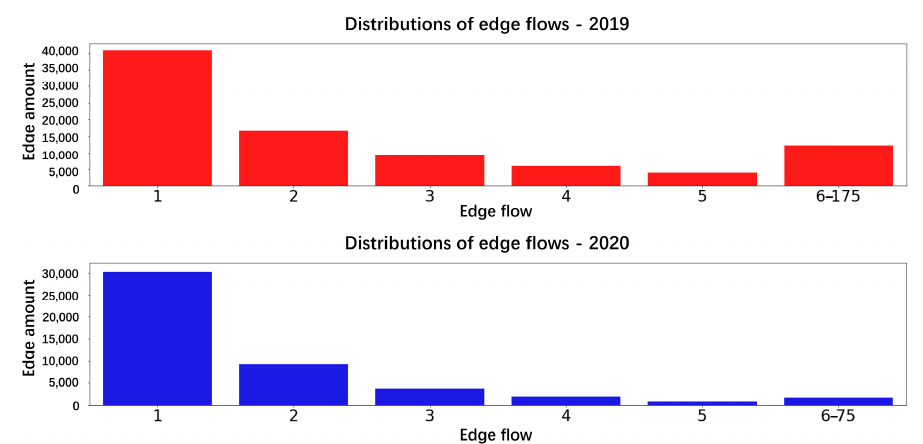
Figure 9. Bike-sharing networks of the first four Wednesdays in ( a ) 2019 and ( b ) 2020.